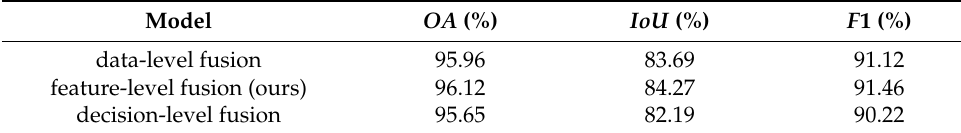
Table 6. Building extraction accuracy of different fusion methods.